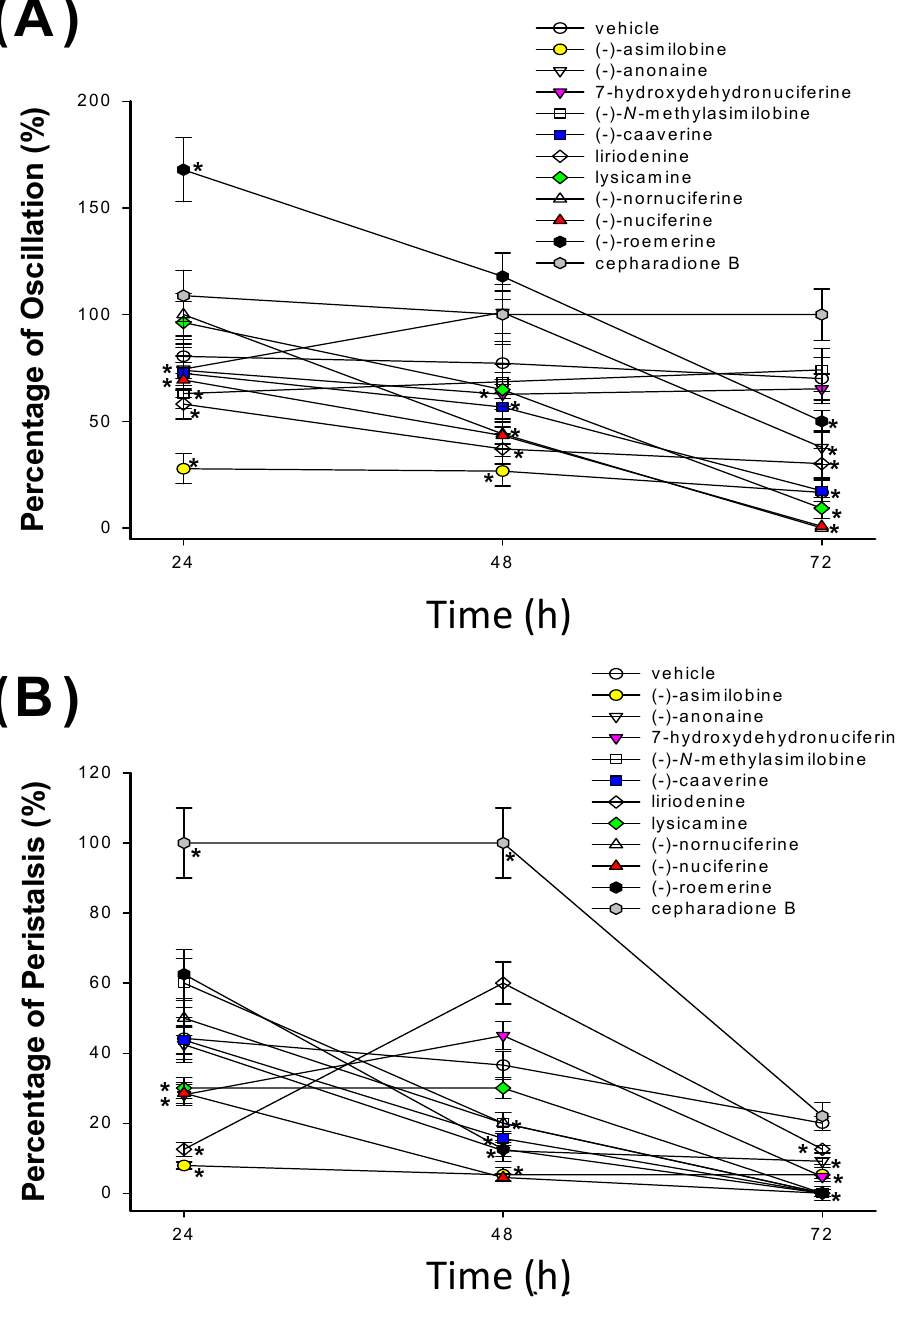
Figure 4. Effect of chemical constituents of Nelumbo nucifera Gaertn. cv. Rosa-plena . on H. nana . Treatment of liriodenine ( 1 ), lysicamine ( 2 ), (-)-anonaine ( 3 ), (-)-asimilobine ( 4 ), (-)-caaverine ( 5 ), (-)- N -methylasimilobine ( 6 ), (-)-nuciferine ( 7 ), (-)-nornuciferine ( 8 ), (-)-roemerine ( 9 ), 7-hydroxydehydronuciferine ( 10 ) and cepharadione B ( 11 ) (100 μ M) with incubation times of 24, 48 and 72 h on H. nana , respectively. Time course of effect on oscillation ( A) and peristalsis ( B ) of H. nana of test compounds presented as percentages. Vehicle is 0.1% DMSO solvent. Each value is presented as mean ± SD of three individual experiments; * p < 0.05 indicates a significant difference from the result for vehicle-treated